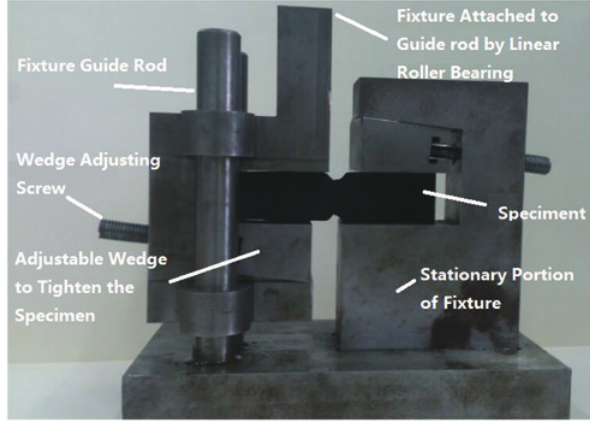
Figure 5: Fixture and a specimen for the shear test.